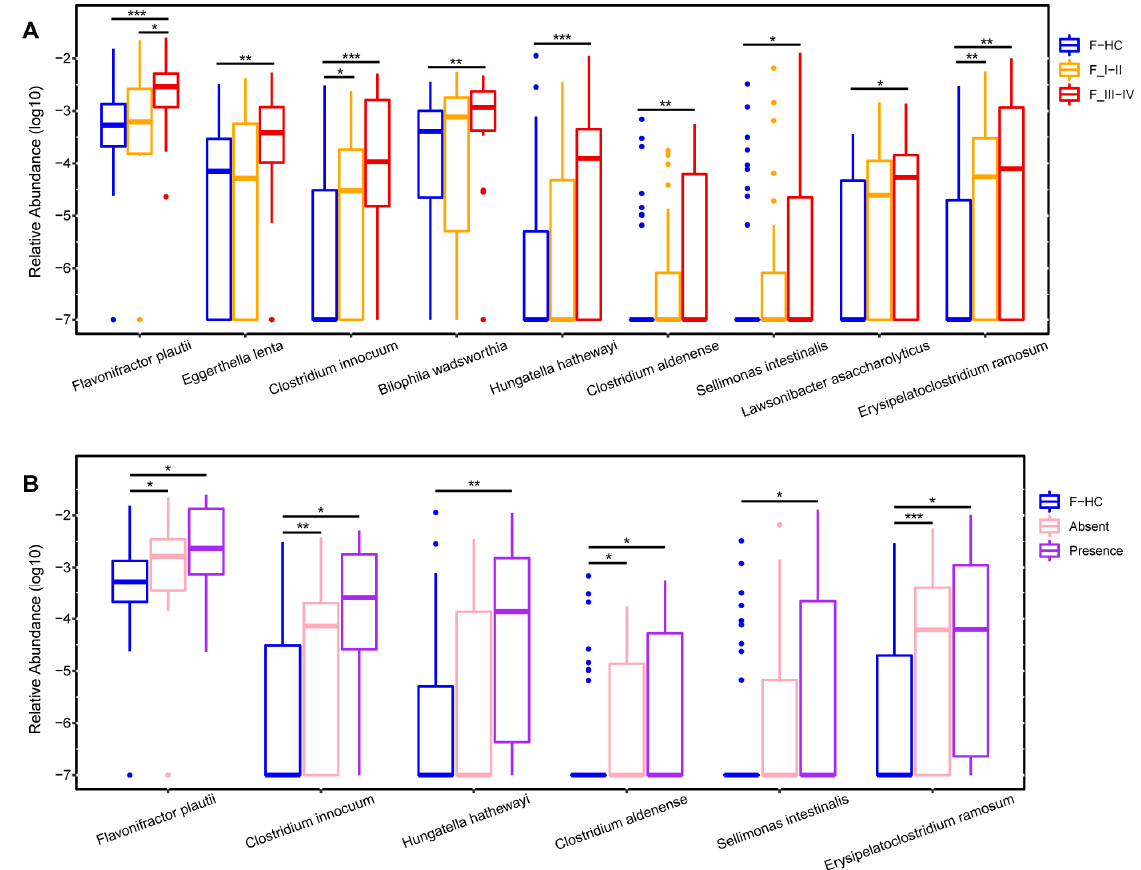
Figure 3. The species significantly increased in the gut microbiota of LADC patients with cancer progression. Boxplots show the relative abundances of species that gradually increased from early- stage to late-stage patients ( A ) and as patients developed distant metastases ( B ) compared with healthy controls. F-HC, healthy control group (n = 64); F_I–II, early-stage LADC group (n = 23); F_III–IV, advanced-stage LADC group (n = 20); F-Absence, non-metastatic LADC group (n = 33); F- Presence, metastatic LADC group (n = 10); p values were calculated using the two-tailed Wilcoxon rank-sum test, ***, p < 0.001; **, p < 0.01; *, p < 0.05.